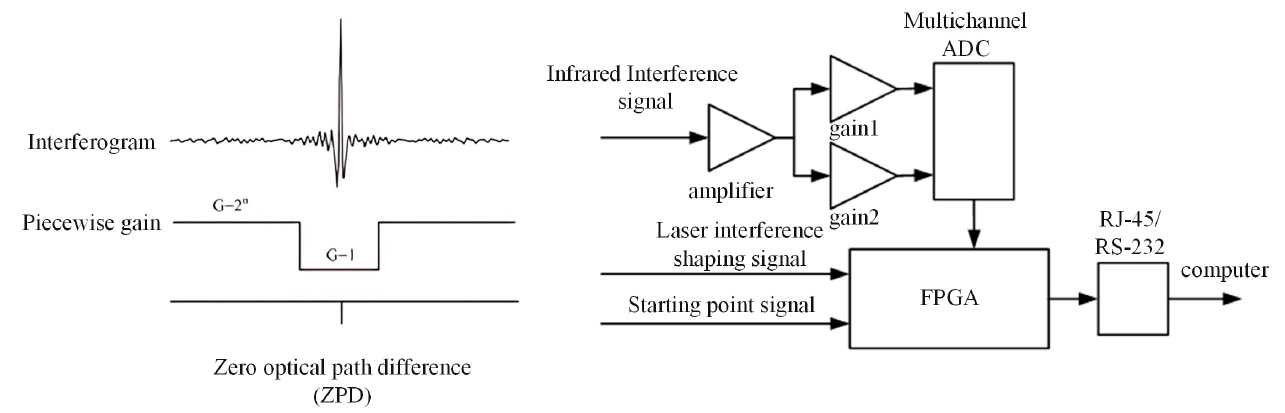
Figure 4. Schematic Diagram of Sectional Variable Gain Circuit Scheme Design.